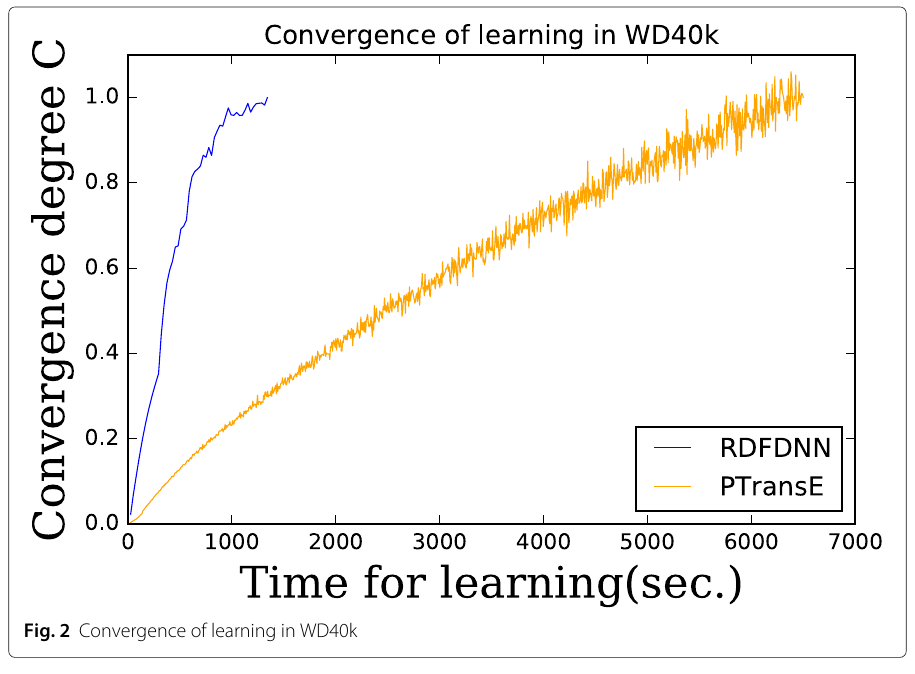
Fig. 2 Convergence of learning in